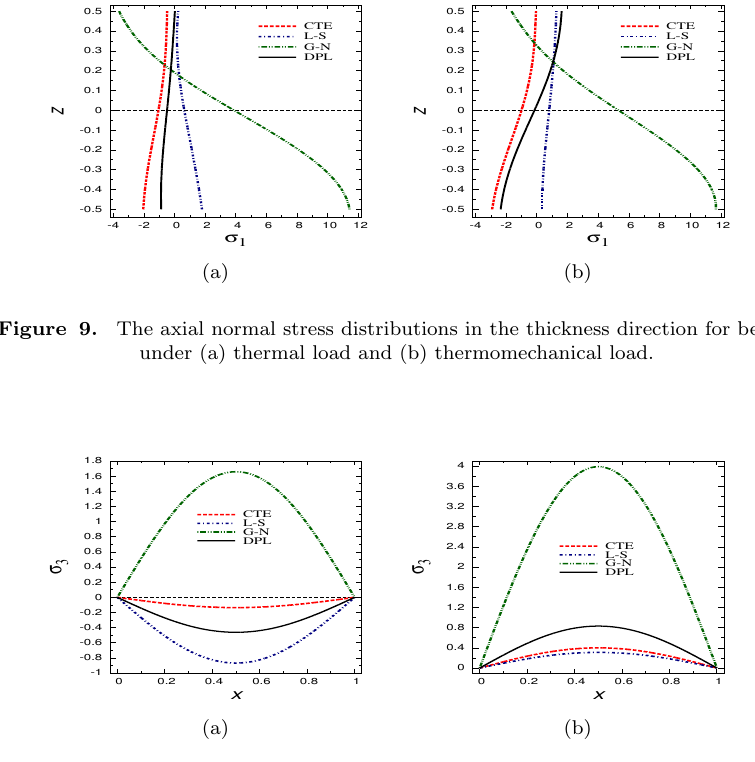
(compression) stresses at the upper (bottom) surface of the beam. However, the L-S (CTE) model gives tensile (compressive) stresses through-the-thickness of the